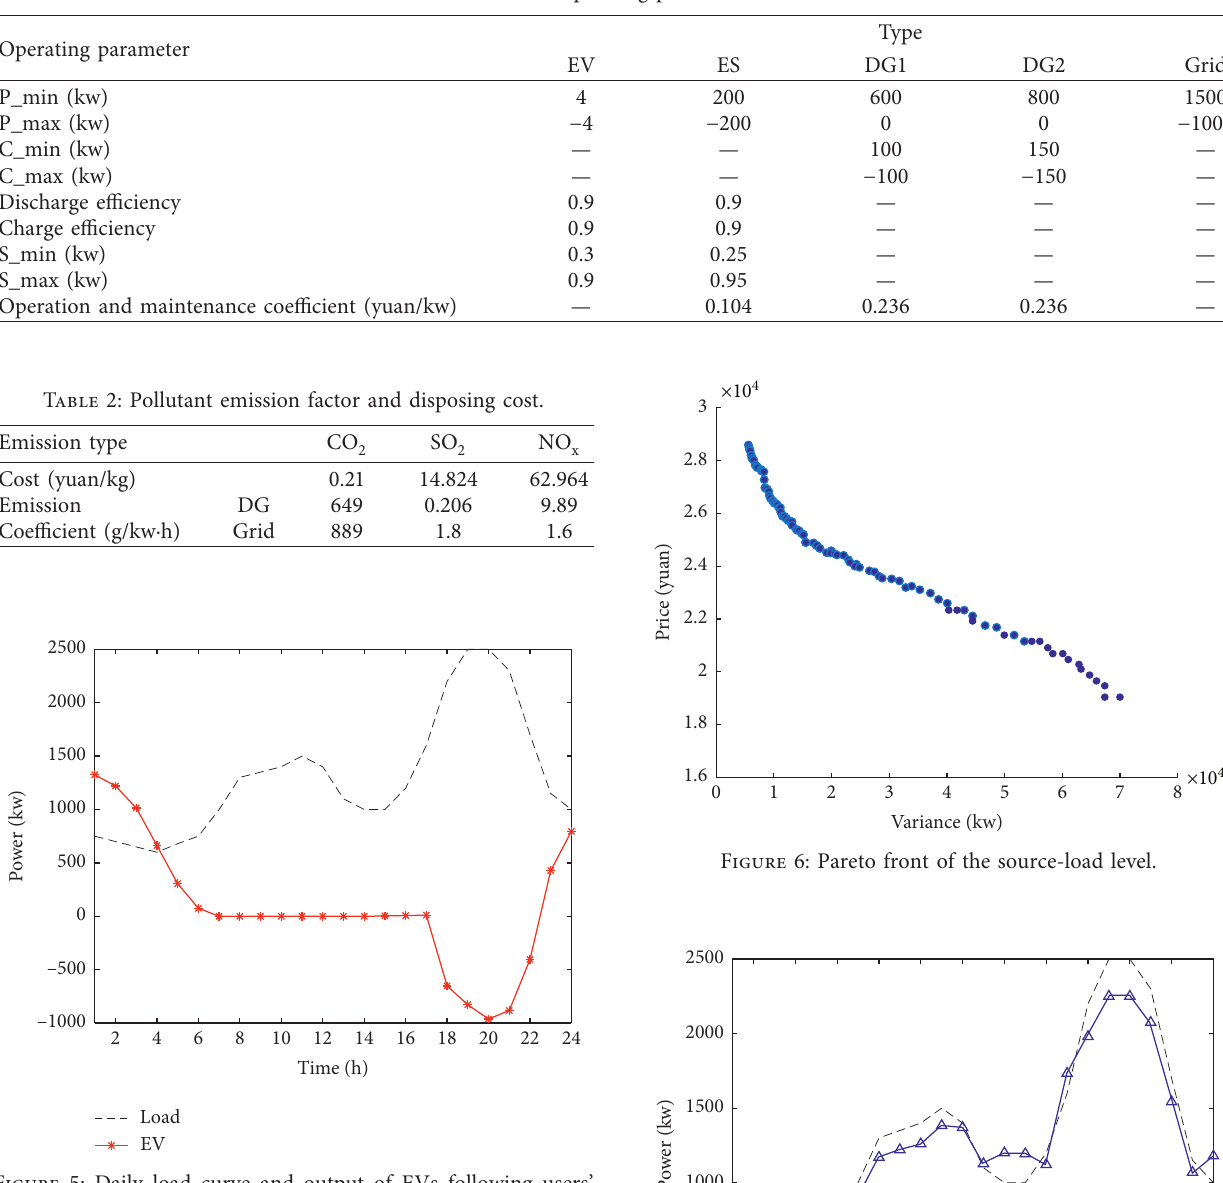
Table 1: Operating parameters.